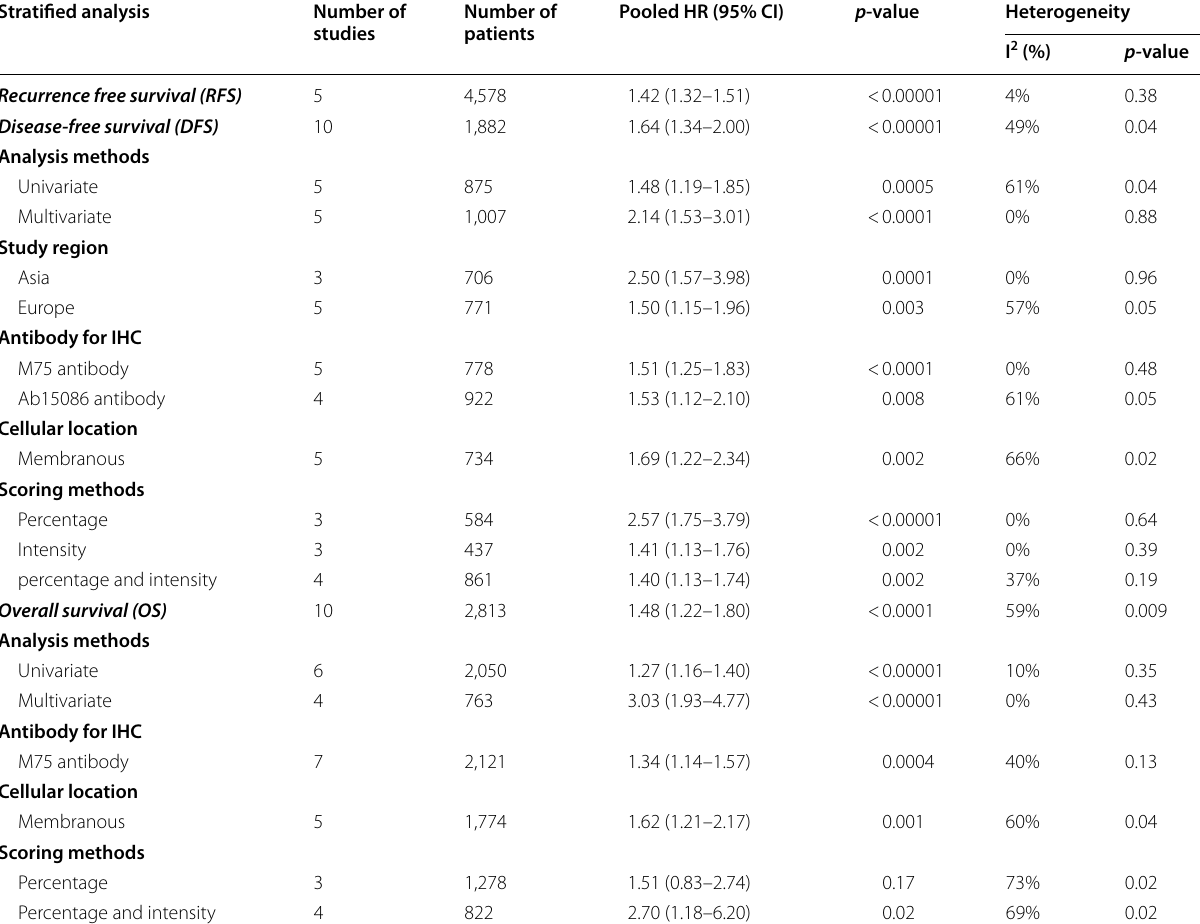
Table 4 Results of meta-analysis and subgroups of analysis methods, study region, different antibodies, cellular location, and scoring methods